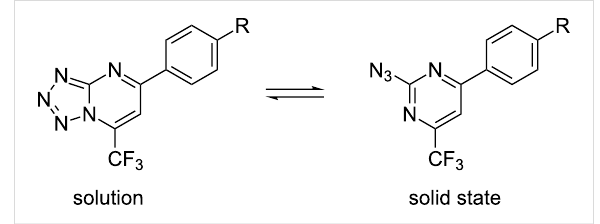
Figure 5: Tetrazolo[1,5- a ]pyrimidine observed in solution (CDCl 3 and DMSO- d 6 ) and 2-azidopyrimidine observed in the solid state based on equilibrium.